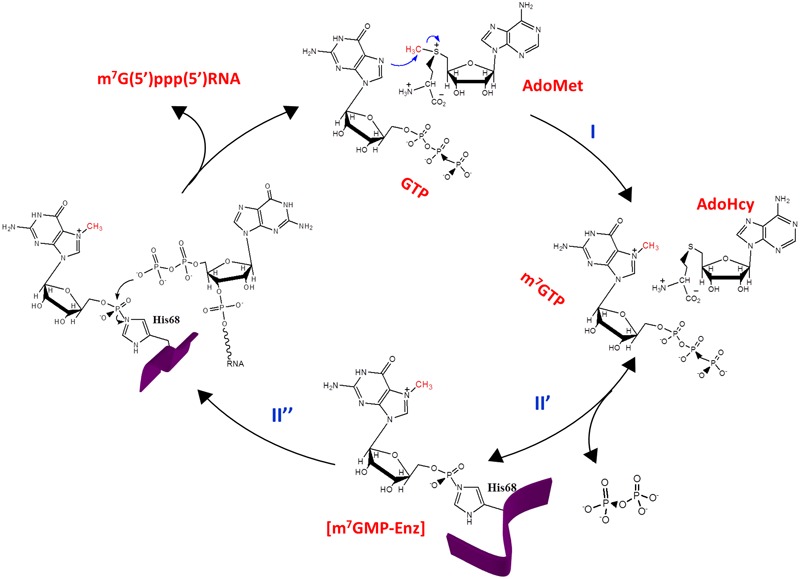
The cap0 formation pathway of BaMV. The AdoMet-dependent guanylyltransferase activity exhibited by REPBaMV is composed of activities of (I) GTP methyltransferase and (II) m7GTP:RNA guanylyltransferase, which can be further divided into two half reactions with the [m7GMP-enzyme] adduct as the intermediate.